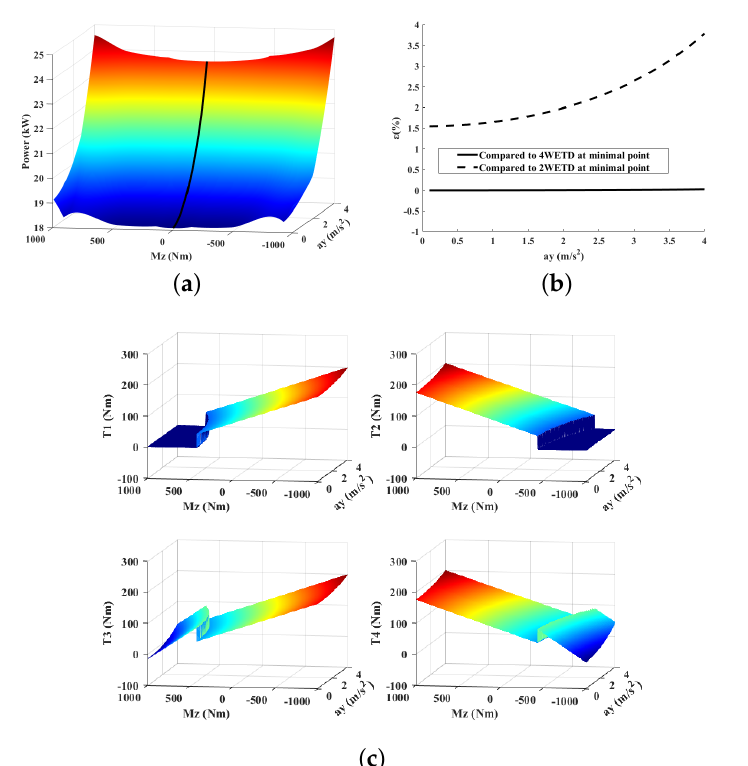
Figure 7. Results for acceleration during cornering with Motor II: ( a ) Minimal power; ( b ) Percentage of energy saving; ( c ) Optimal wheel